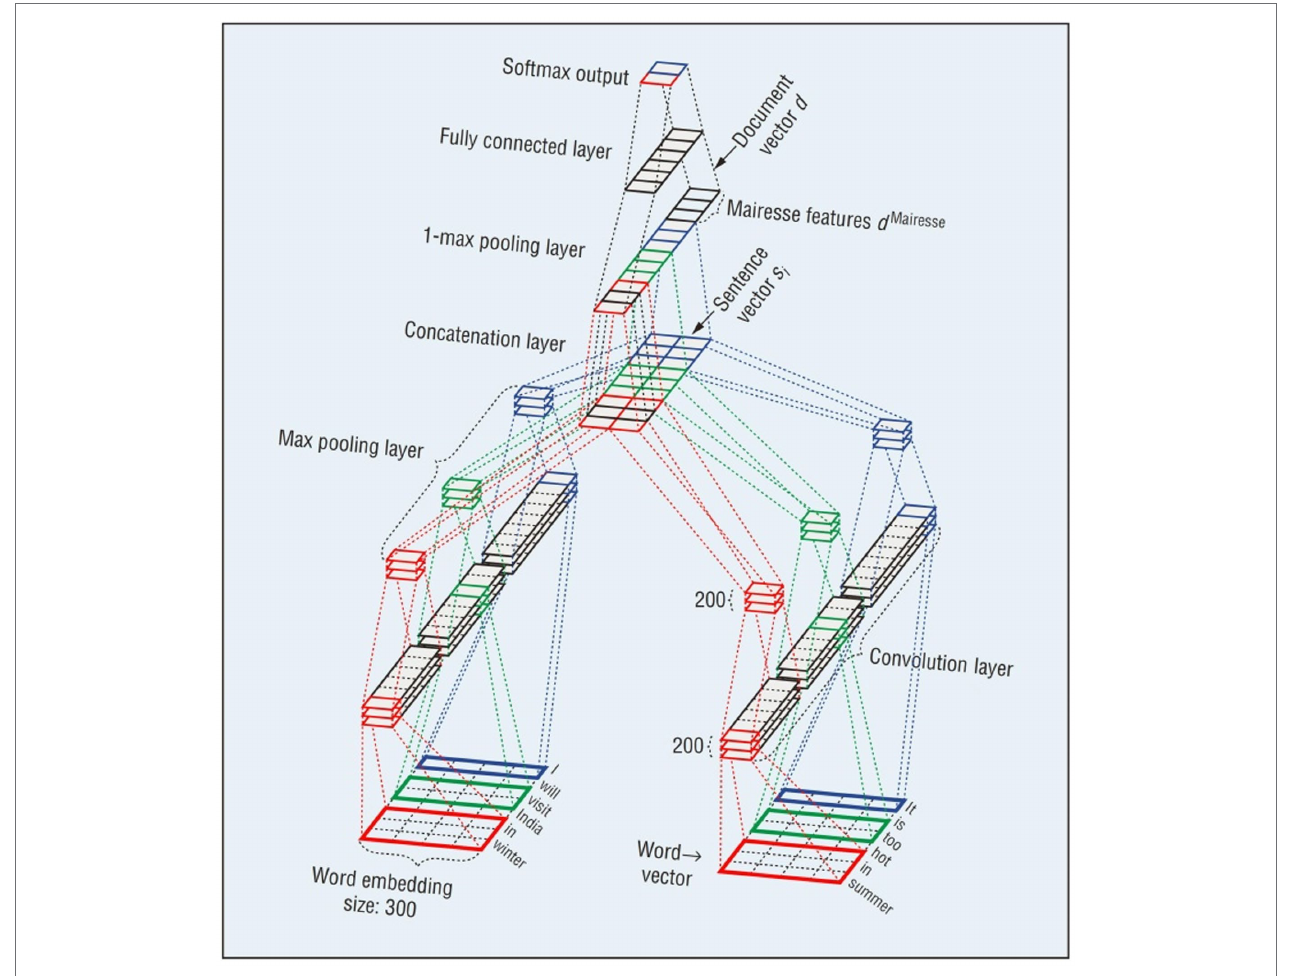
FIGURE 5 | The flowchart of CNN-based document-level personality prediction from text (Majumder et al.,